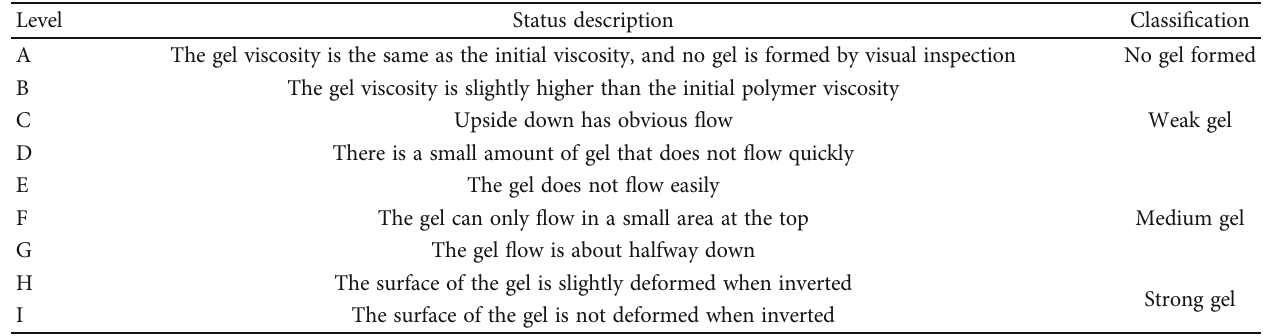
Table 3: Observation method to evaluate gel standards.